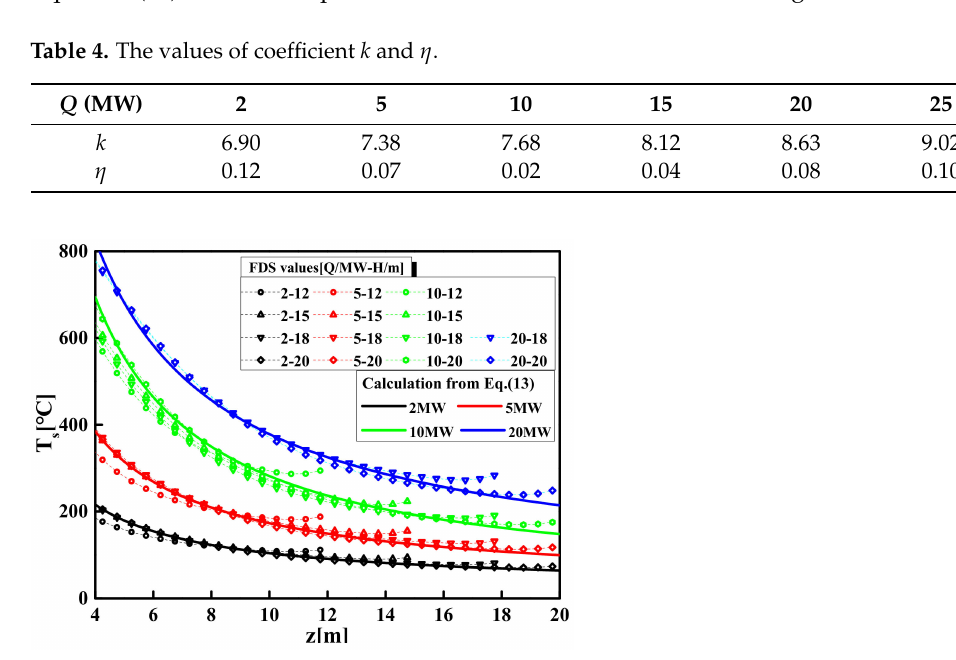
Figure 14. Comparisons of prediction and FDS simulation of centerline